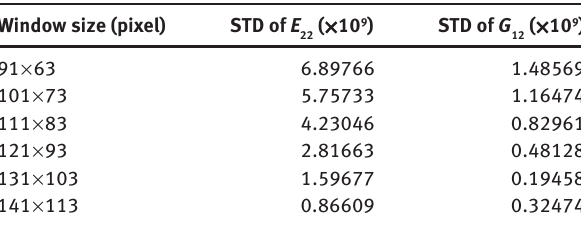
Table 5: The STD of elastic properties varied with window